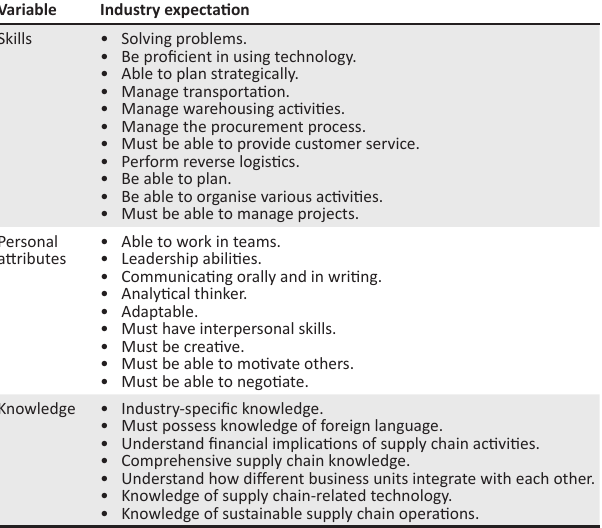
TABLE 3: Consolidated list of international industry expectations of new supply chain graduates. Variable Industry